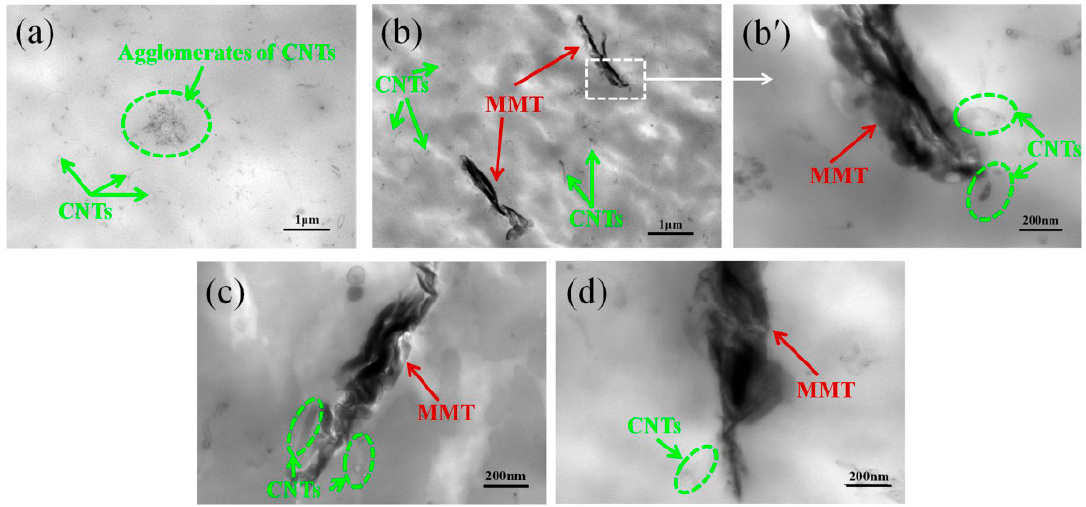
Figure 5. Representative TEM images of ( a ) PEEKC1 and ( b ) PEEKC1M1, ( b ′ ) is a partially enlarged image of ( b ), ( c ) PEEKC1M2, ( d ) PEEKC1M4.